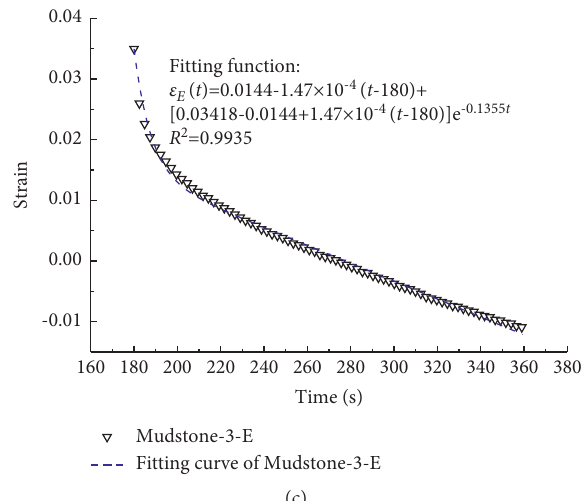
Figure 7: Fitting results of elastic aftereffect curves of (a) mudstone-1, (b) mudstone-2, and (c) mudstone-3 by using the elastic aftereffect equation of the simplified Burgers model.